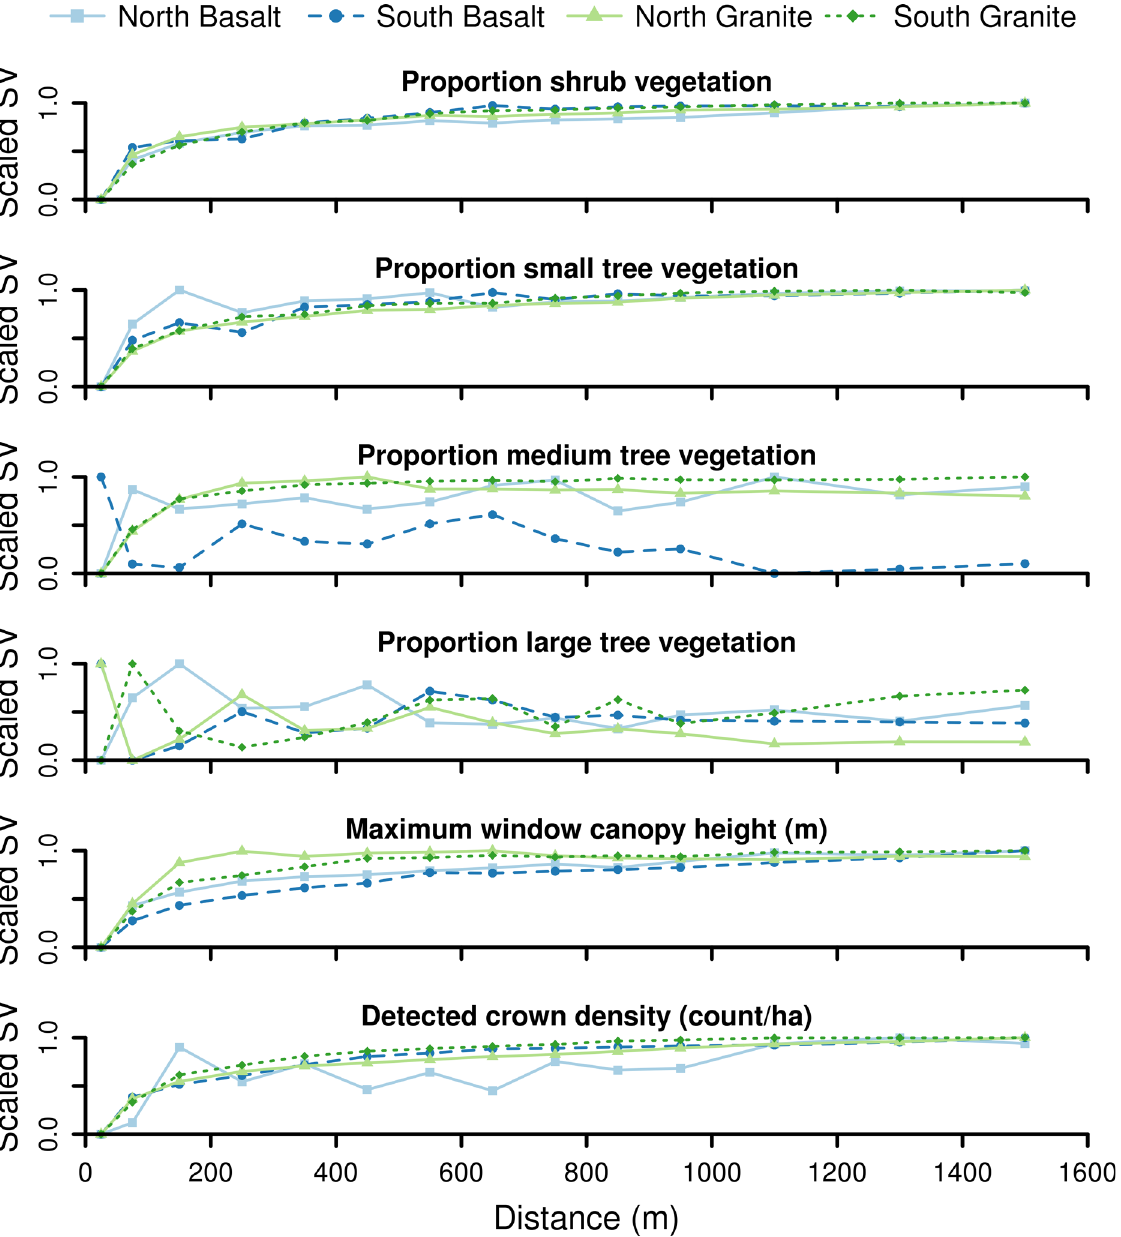
Fig 4. Spatial covariance of the vegetation structure metrics. Variograms showing the extent of spatial covariance of the six vegetation structure metrics for each of the four watersheds. In each of the variograms, semi-variance (SV) is scaled to span the interval [0,1] for better comparison of the range of spatial dependence between watersheds. Proportion vegetation is defined as the proportion of area in a 16.8 x 16.8 m window of the vegetation height map that is in the given height class: 0.5 to 2.5 m (shrub), 2.5 to 5.0 m (small tree), 5.0 to 10.0 m (medium tree), and > 10.0 m (large